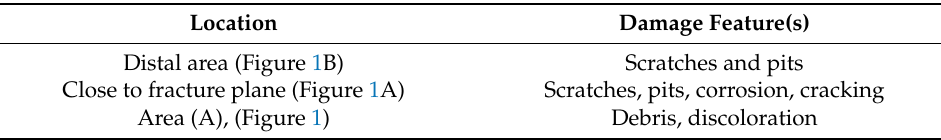
Table 3. Various damage features on different parts of implant.